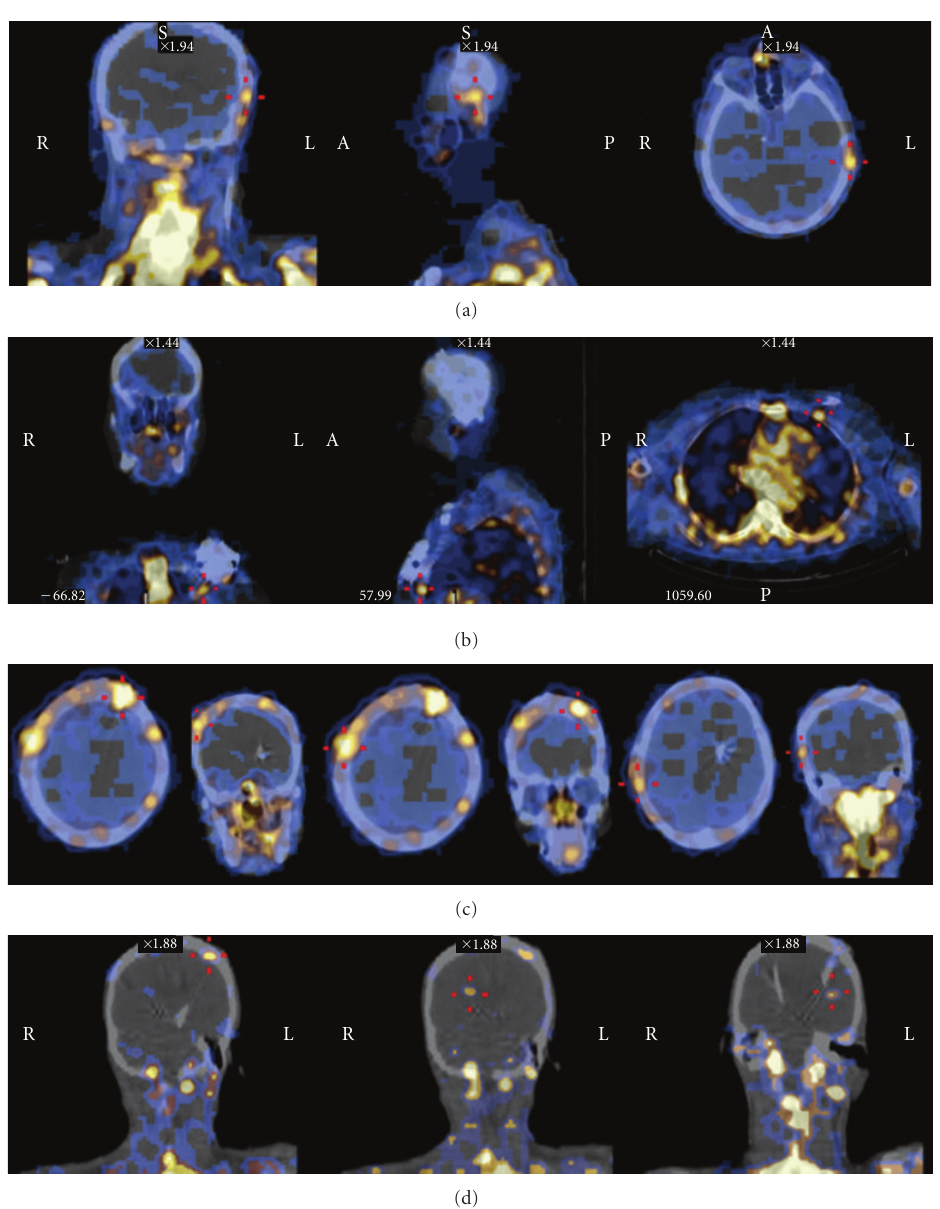
Figure 1: 99m Tc-sulesomab immunoscintigraphy (SPECT/CT fusion images). (a) Three plane images of Patient 2, showing focal tracer uptake restricted to the subcutaneous left temporal area, corresponding to the connector site. (b) Three plane images of Patient 7, showing left chest wall focal tracer uptake, in the area corresponding to the IPG pouch. (c) Axial and coronal images of Patient 1, showing di ff use tracer uptake along the extracranial trajectory of the right electrode. (d) Coronal images of Patient 8, showing left frontal and intracranial focal areas of tracer uptake, along the path of the